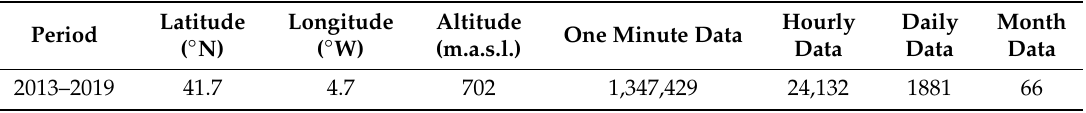
Table 1. Geographical coordinates and database figures for the